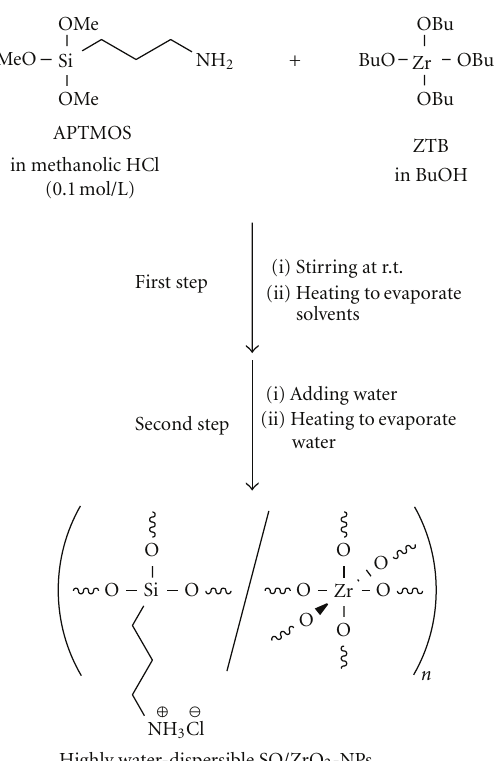
Scheme 1: Preparation of highly water-dispersible SQ/ZrO 2